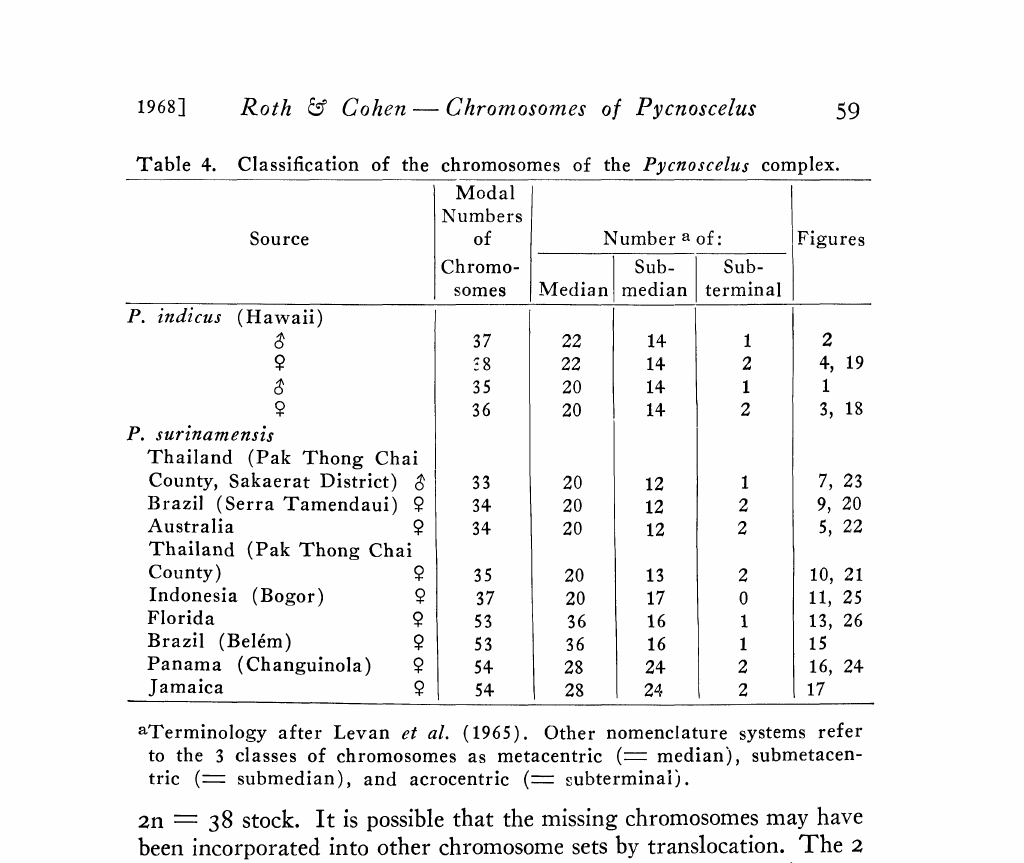
Table 4. Classification o the chromosomes of the Pycnoscelus complex.